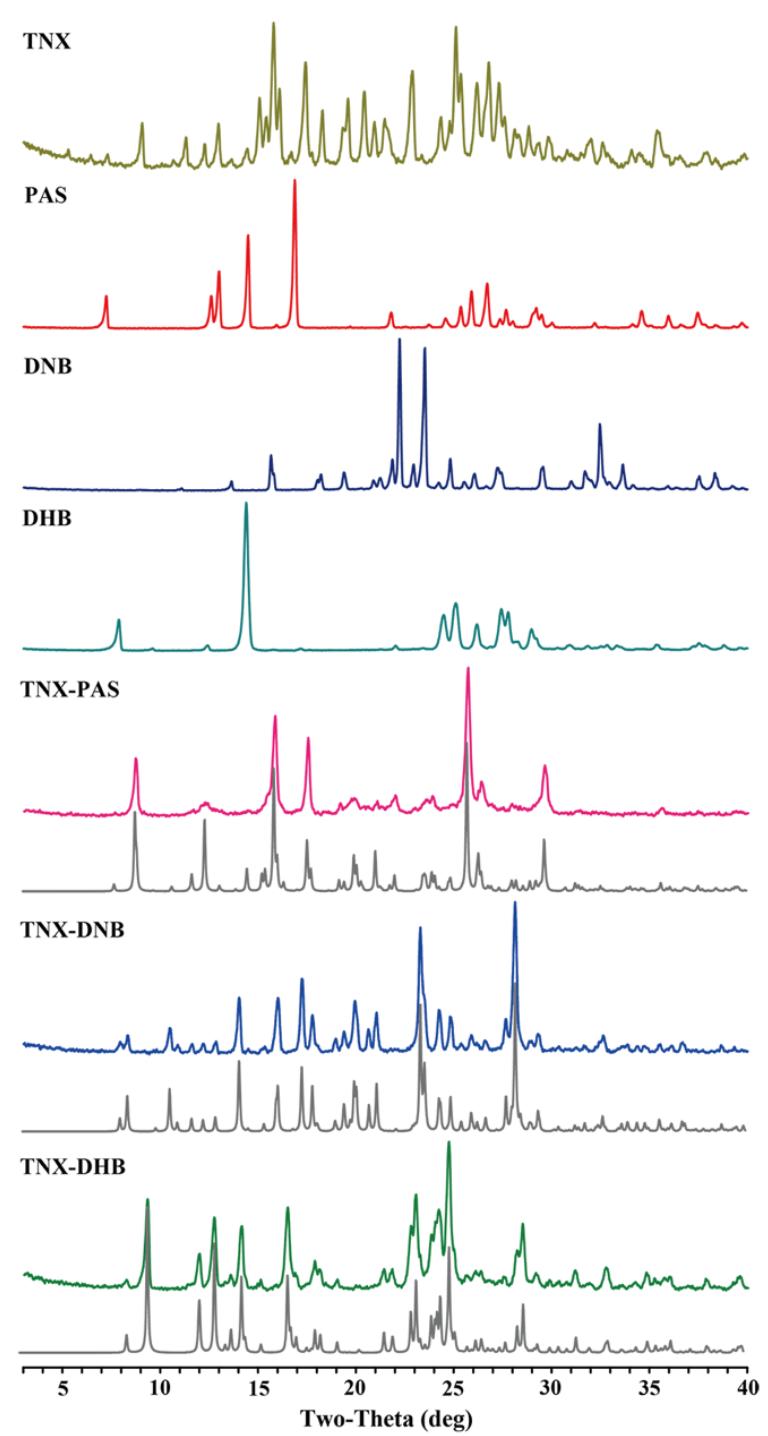
Figure 3. PXRD patterns of TNX, CCFs, and the corresponding cocrystals/salt.